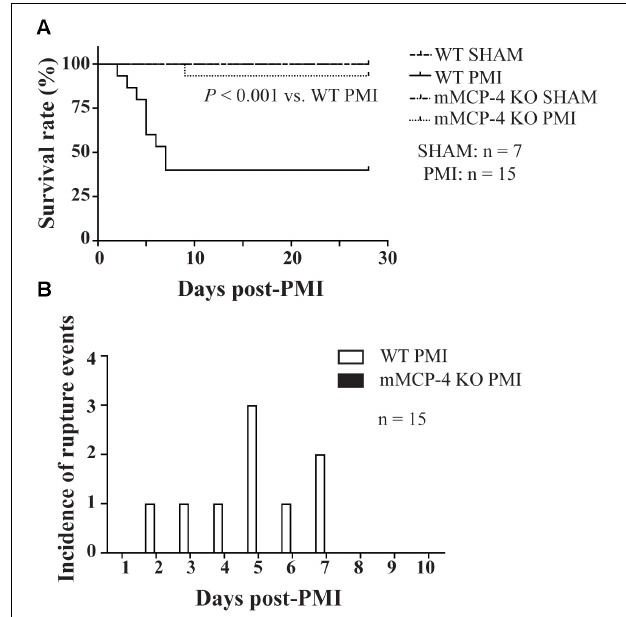
FIGURE 1 | Kaplan-Meier 28-day survival analysis of mouse survival (Mantel-Cox test) (A) and incidence of left ventricular free wall rupture events (B) following LAD coronary artery ligation (A) . PMI: n = 15, SHAM: n = 7.